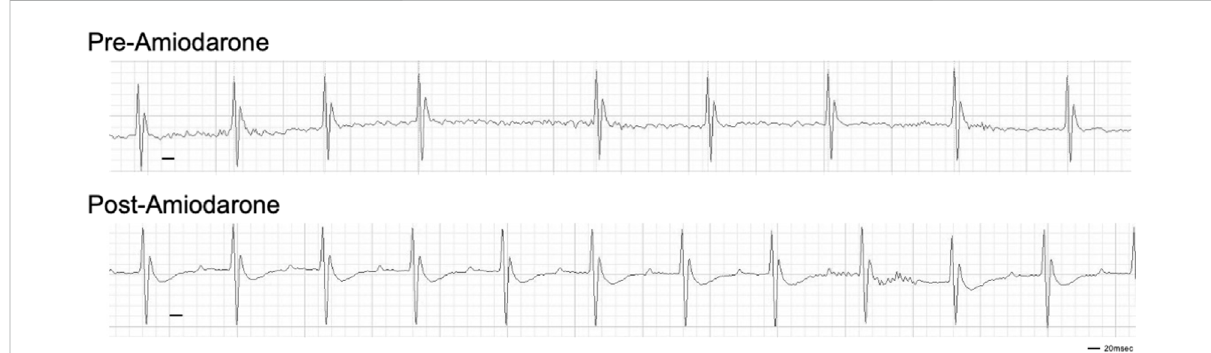
FIGURE 3 Cardioversionbyi.p.injectionofamiodarone.AmiodaronewasinjectedatDay28post-DTinjection.Representativeof9outof11miceinjected with DT that were successfully reverted to sinus